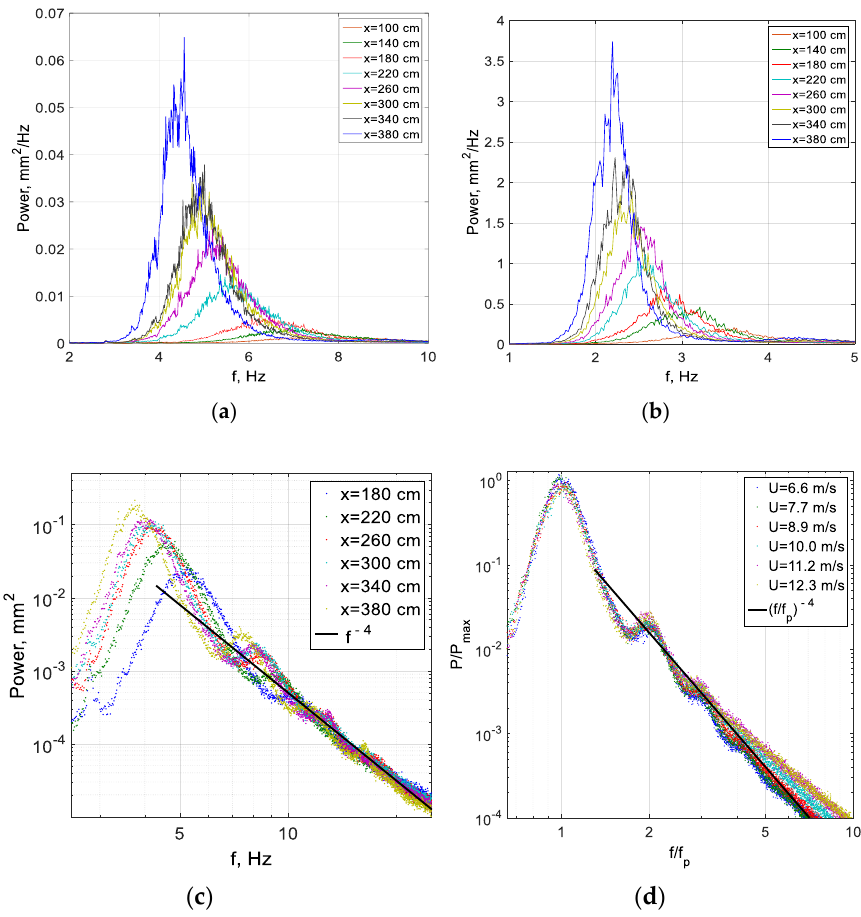
Figure 6. Variation of elevation power spectra along the test section: ( a ) U max = 5.5 m/s; ( b ) U max = 12.3 m/s; ( c ) in semi-log coordinates for different fetches at U max = 6.6 m/s; ( d ) normalized spectra for various wind velocities at x = 260 cm.